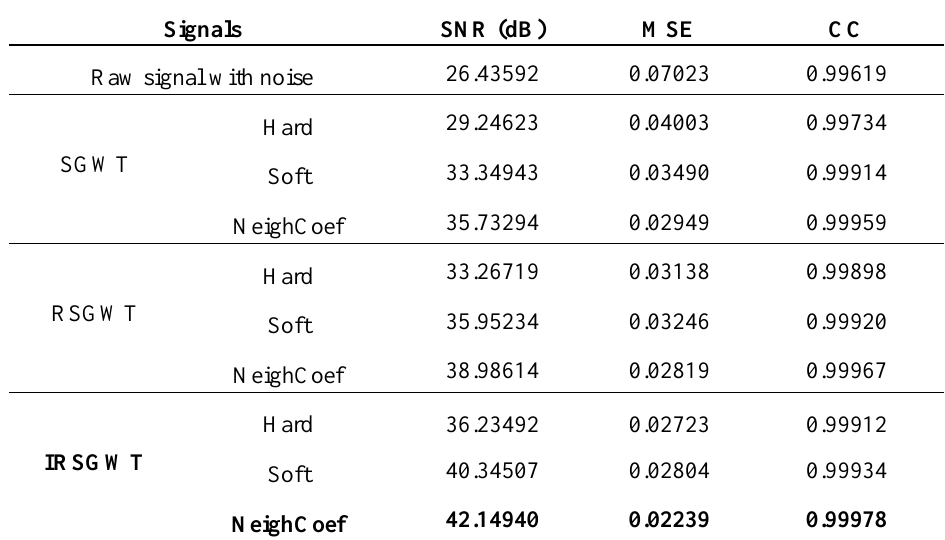
Table 1. The denoising performance indexes of denoising results for the Lamb wave signal.